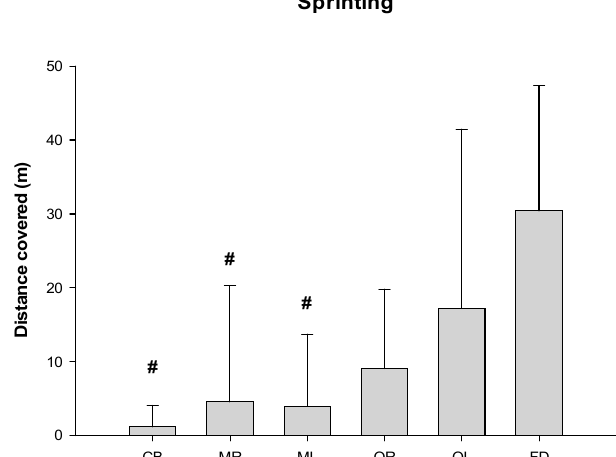
Figure 4. Distance covered in different locomotion categories by playing position in defense. # Statistical differences with front defender p ≤ 0.05; § statistical differences with center back p ≤ 0.05. Legend: center back = CB; mid right = MR; mid left = ML; outside right = OR; outside left = OL; front center defender = FD.